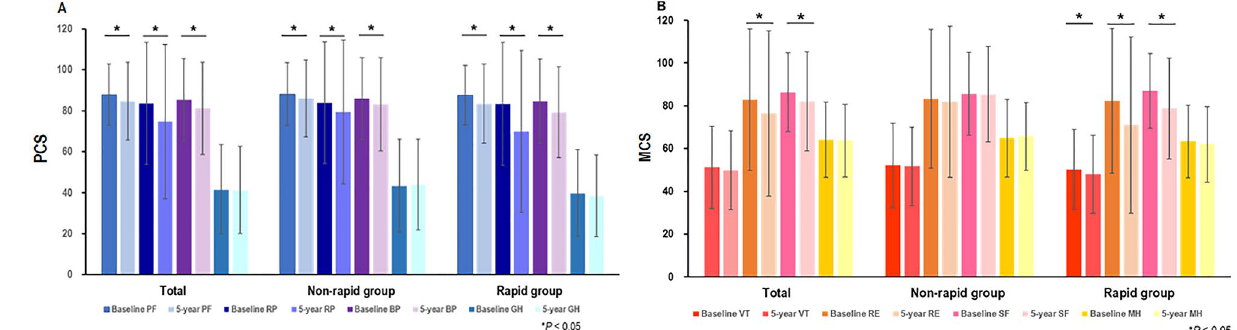
Figure 3. PCS and MCS component changes according to the presence of a rapid decline in kidney function. ( A ) Changes in PCS component scores. The scores for physical function, role-physical, and bodily pain decreased significantly at 5 years in the entire group, as well as in the non-rapid and rapid kidney function decline groups. ( B ) Changes in MCS component scores. The scores for role-emotional and social function decreased at the 5-year follow-up. In the rapid kidney function decline group, those for vitality, role-emotional, and social function significantly decreased at the 5-year follow-up. However, no significant decrease in the MCS score was observed in the non-rapid kidney function decline group during the follow-up period. PCS, physical component summary; PF, physical function; RP, role-physical; BP, bodily pain; GH, general health; MCS, mental